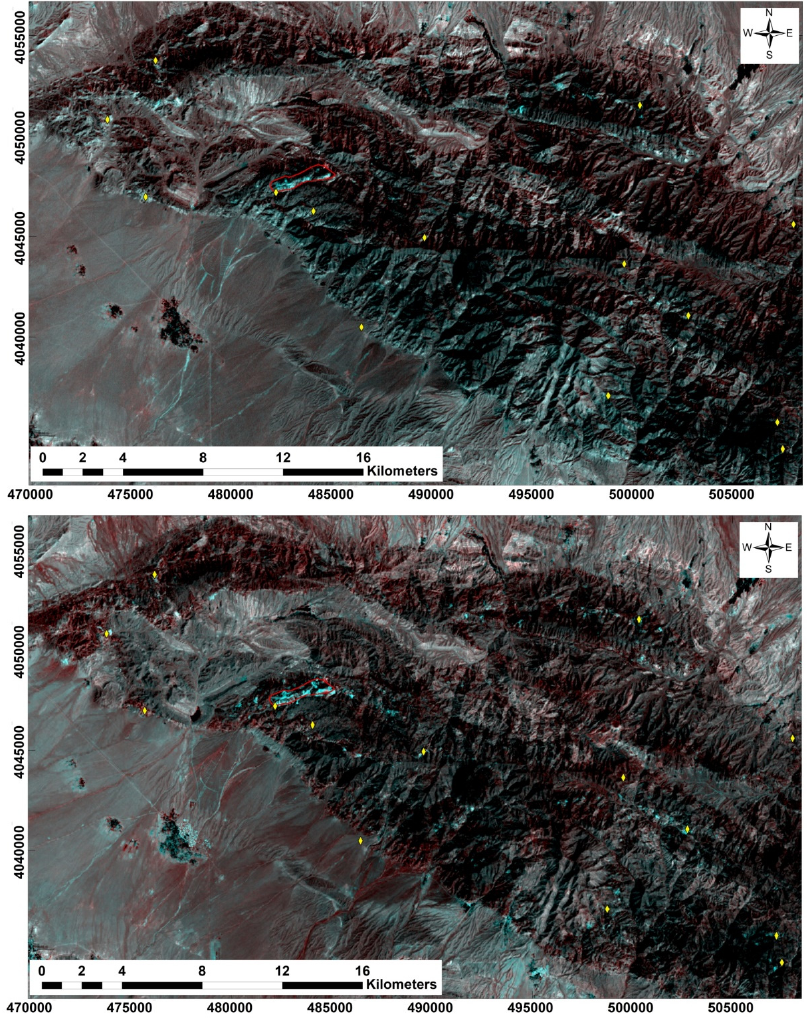
Figure 5. The results of applying the change detection algorithm. The ( upper ) image shows the difference map between TM (1986) and ETM+ (1999), and the ( lower ) image shows the difference map between ETM and LC8 (2021). The changed areas are marked as bright cyan color pixels. The location of chromite indexes is shown as yellow diamonds, and the area with a large amount of mining activity is outlined as a red